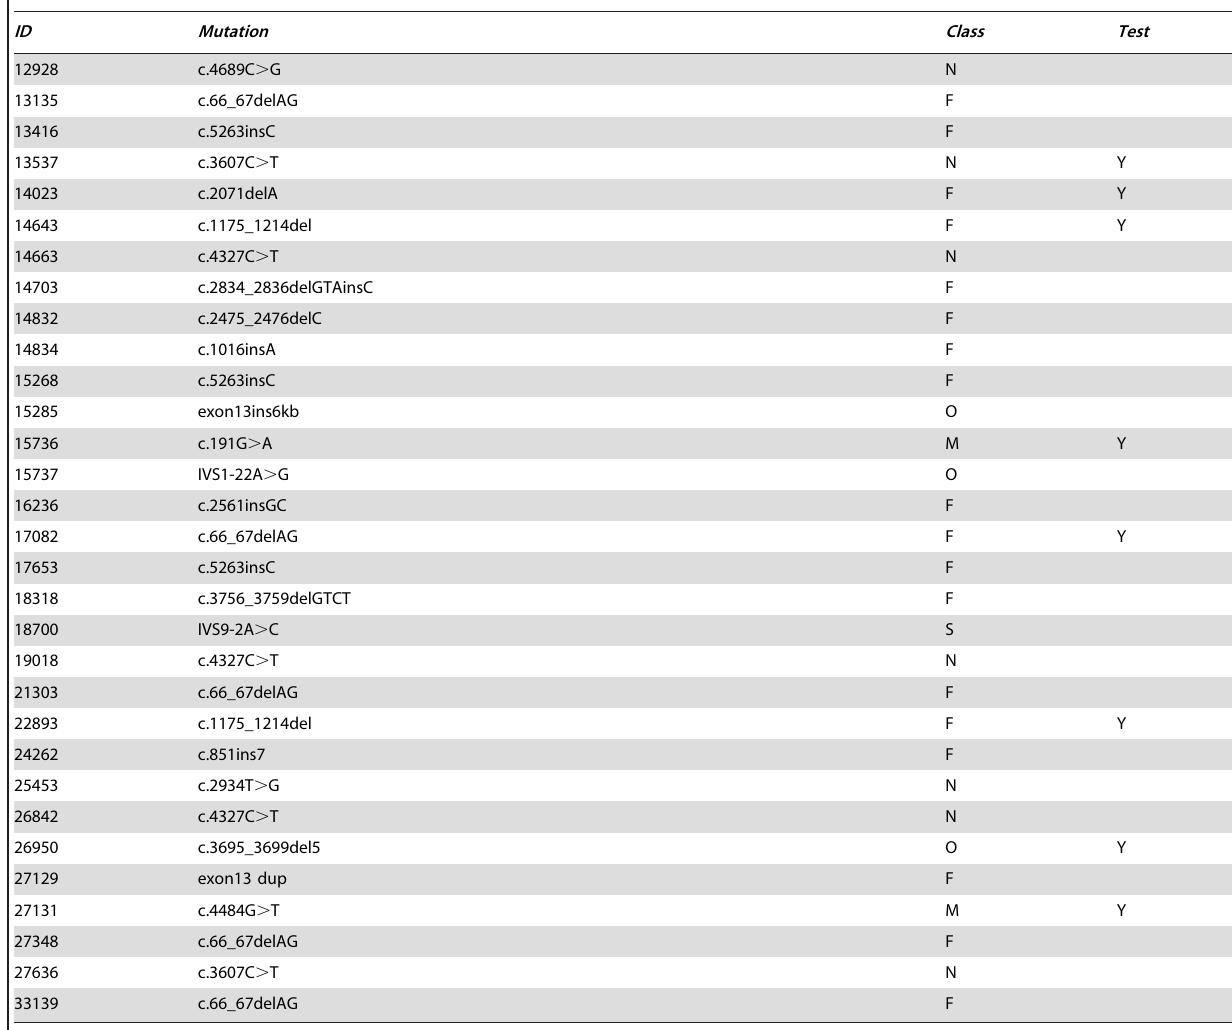
Table 1. List of BRCA1 mutations used in this